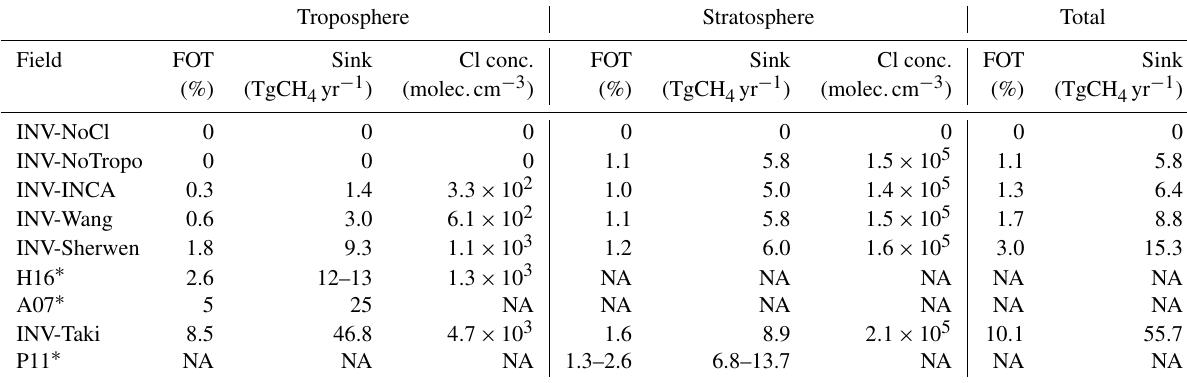
Table 4. Fraction of the Cl sink to the total (FOT) chemical sink (Cl, O( 1 D), and OH), Cl sink intensity (Sink), and mean Cl concentration (Cl conc.). Values are given for the tropospheric, stratospheric, and total (tropospheric + stratospheric) Cl sinks for several fields, either used in the simulations or in other